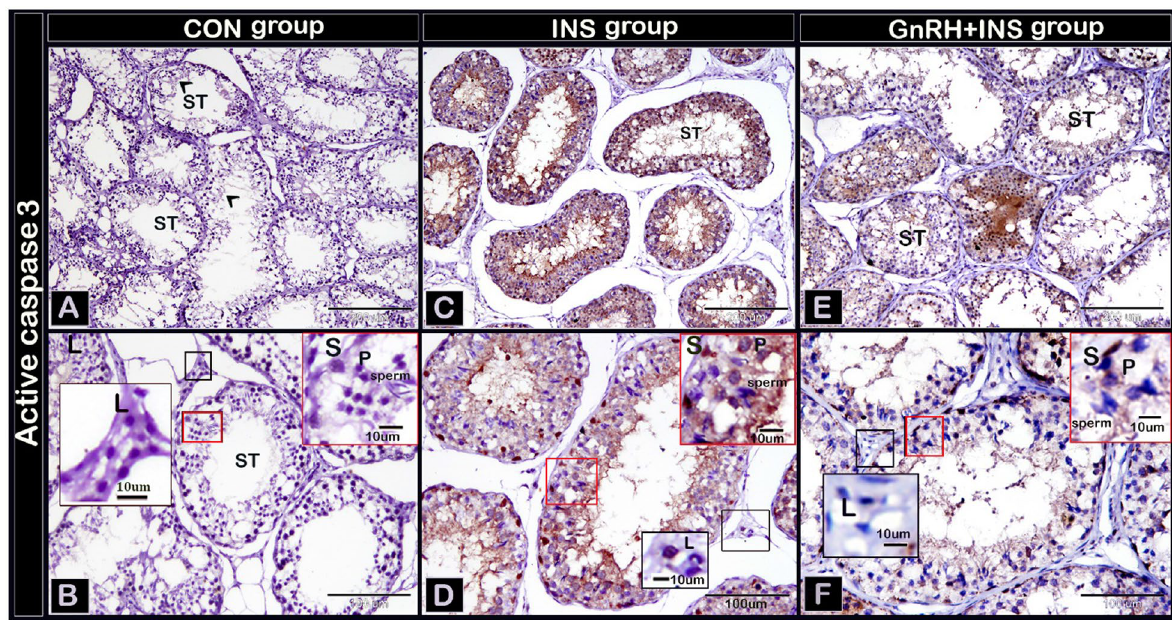
Figure 2. Photomicrographs of paraffin testicular sections stained with immunohistochemistry to detect the expression of active caspases-3: A , C , E (low magnification, X100), B , D , and F (higher magnification: X200). The CON group ( A and B ) showing a weak expression of caspases-3 immunostaining. Note: Arrowhead points to the reaction in sperm. The INS group ( C and D ) showing moderate expression of caspases-3 immunostaining. While, GnRH + INS group ( E and F ) showing the lowest expression of caspase-3 in Sertoli, germ and Leydig cells were decreased in comparison to insulated group. Abbreviation: ST: seminiferous tubules, S: Sertoli cells, P: primary spermatocytes, L: Leydig cells. The inserted squares highlight the reaction; red squares highlight the reaction in Sertoli and germ cells, and the black squares highlight the reaction in Leydig